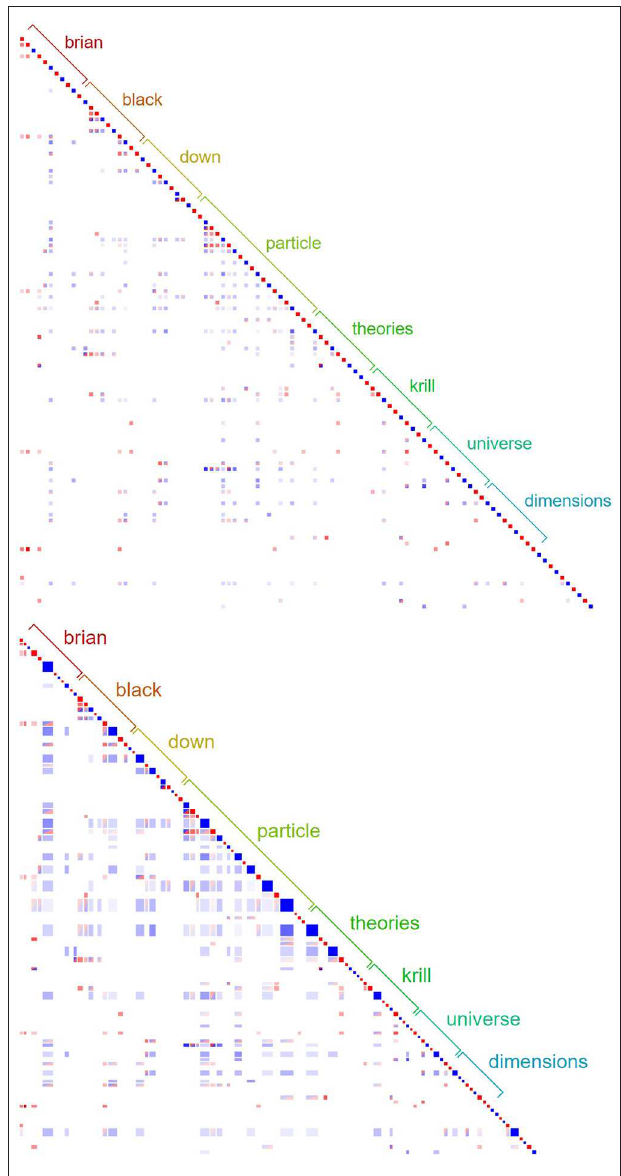
FIGURE 3 | Comparing conceptual recurrence plots with regular vs. proportionally sized recurrence elements (proportional size is based on length of conversation